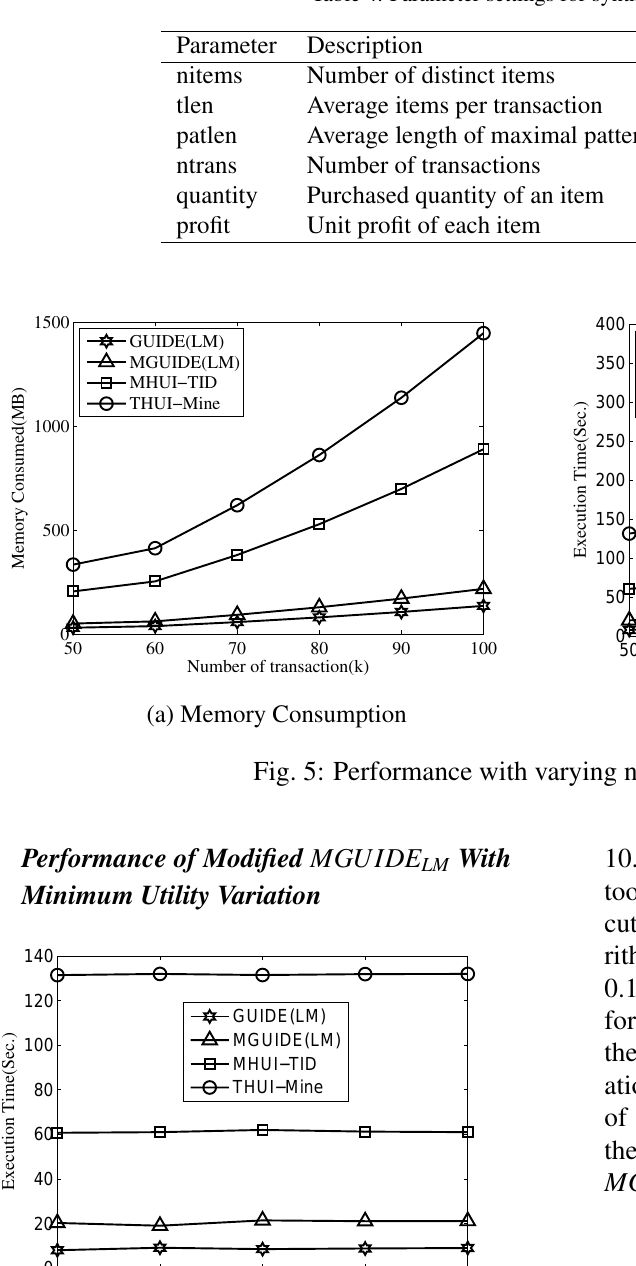
Table 4. Parameter settings for synthetic data generation